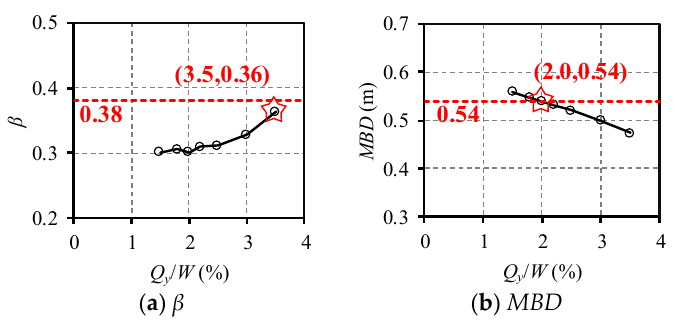
Figure 6. C4 with PBI scheme.